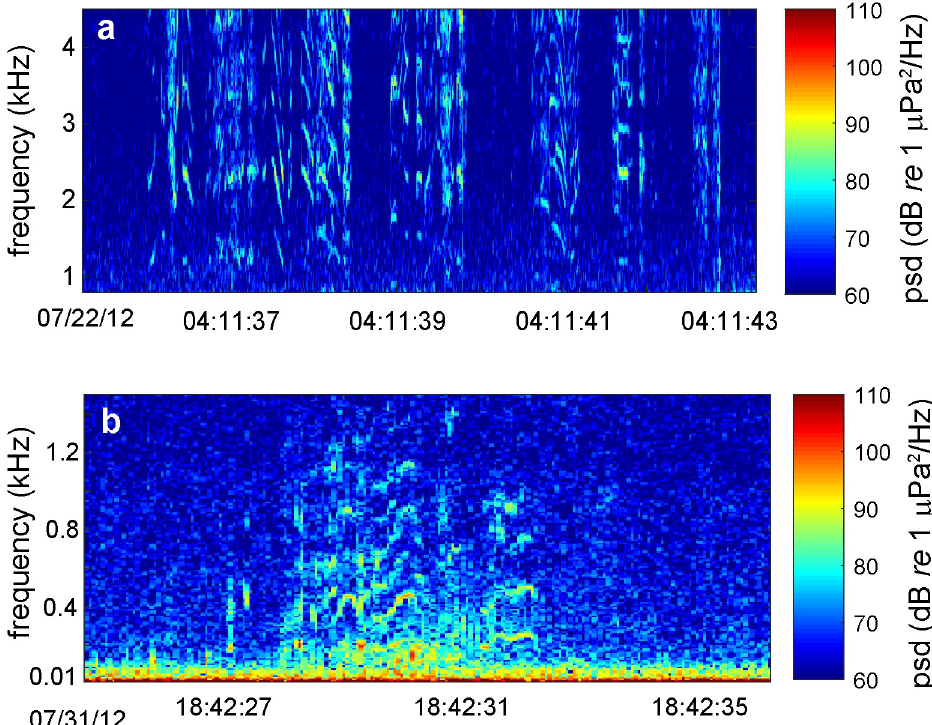
Fig 9. Spectrograms of bioacoustic signals observed along the glider mission. (a) 7 second long spectrogram of the low frequency component of commonly observed Pacific white-sided dolphin whistles (1–4.4 kHz); (b) an 11 second long spectrogram of low frequency (10–1500 Hz) humpback whale vocalizations recorded by the glider.